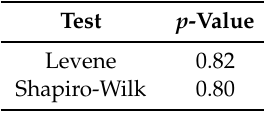
Table 9. Test to ensure the homoscedasticity and the normal distribution of the evaluation results for the coarse-grained classifiers.